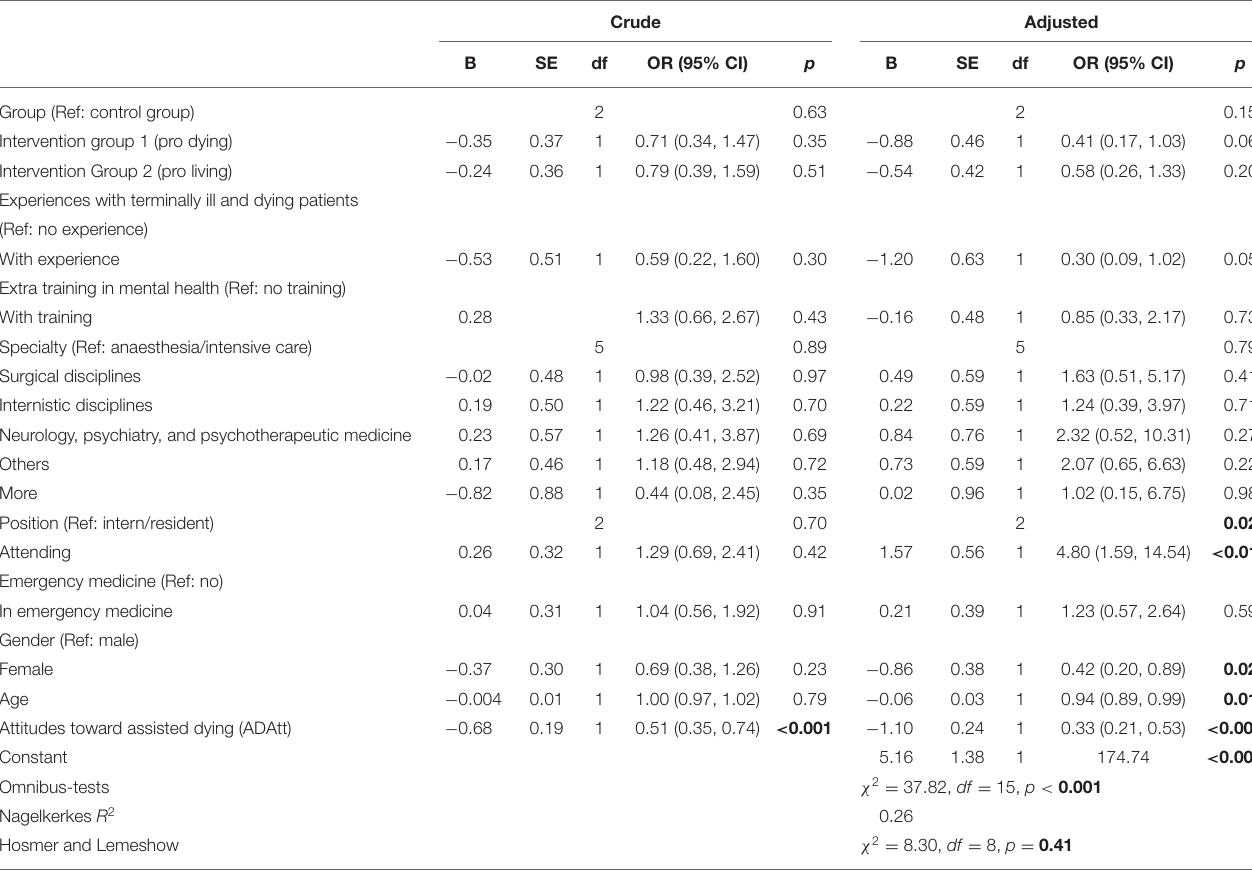
TABLE 2 | Logistic regression analysis for predictors for intentions to initiate life-saving procedures in open case vignette. Crude